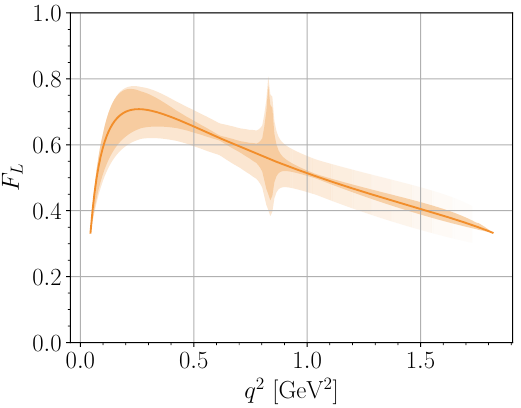
only. The orange band includes in addition C eff R